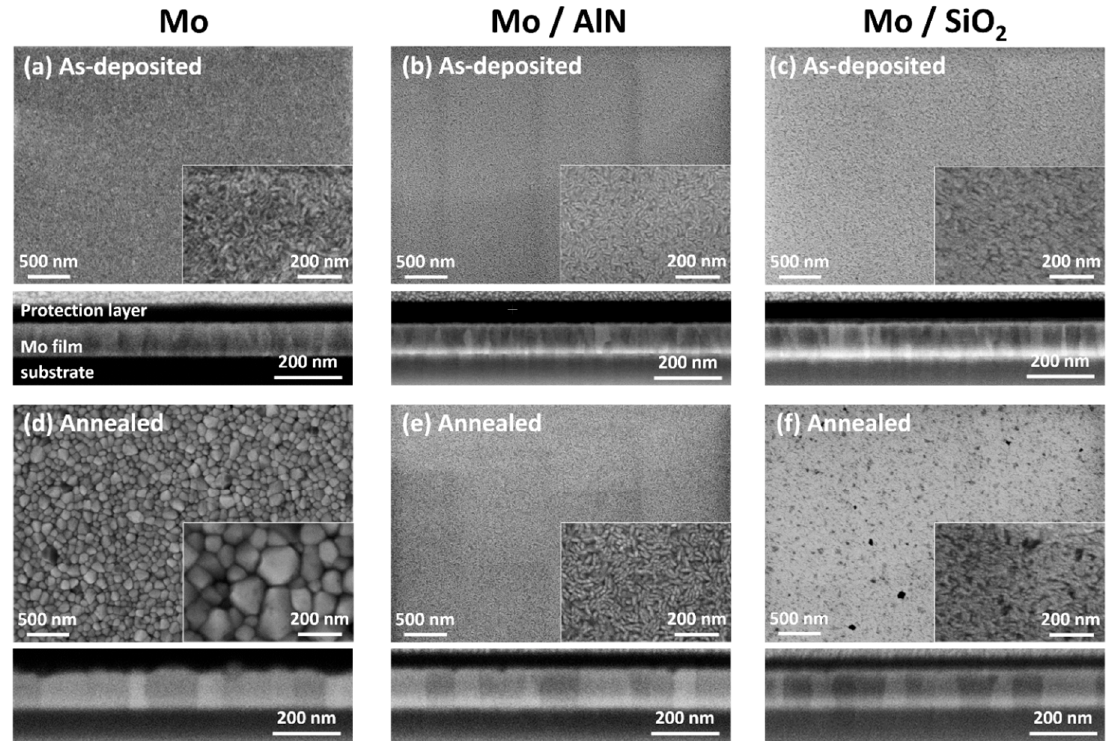
Figure 2. SEM (in-lens, 10 kV) micrographs and focused ion beam technique (FIB)-cut cross section views (in-lens, 3 kV) of ( a ) the as-deposited Mo film, ( b ) the as-deposited Mo film with AlN cover layer, ( c ) the as-deposited Mo film with SiO 2 cover layer, ( d ) the annealed Mo film, ( e ) the annealed Mo film with AlN cover layer, and ( f ) the annealed Mo film with SiO 2 cover layer. Cover layers (AlN and SiO 2 ) are not visible in the FIB micrographs due to the low contrast between the cover layers and the FIB protection layer. The vertical stripes observed in ( b , e ) are caused by sample surface charging.